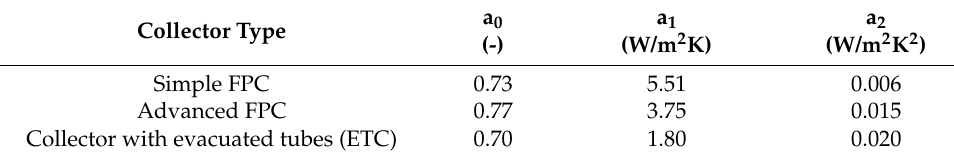
Table 1. Thermal efficiency coefficients of the examined solar technologies.